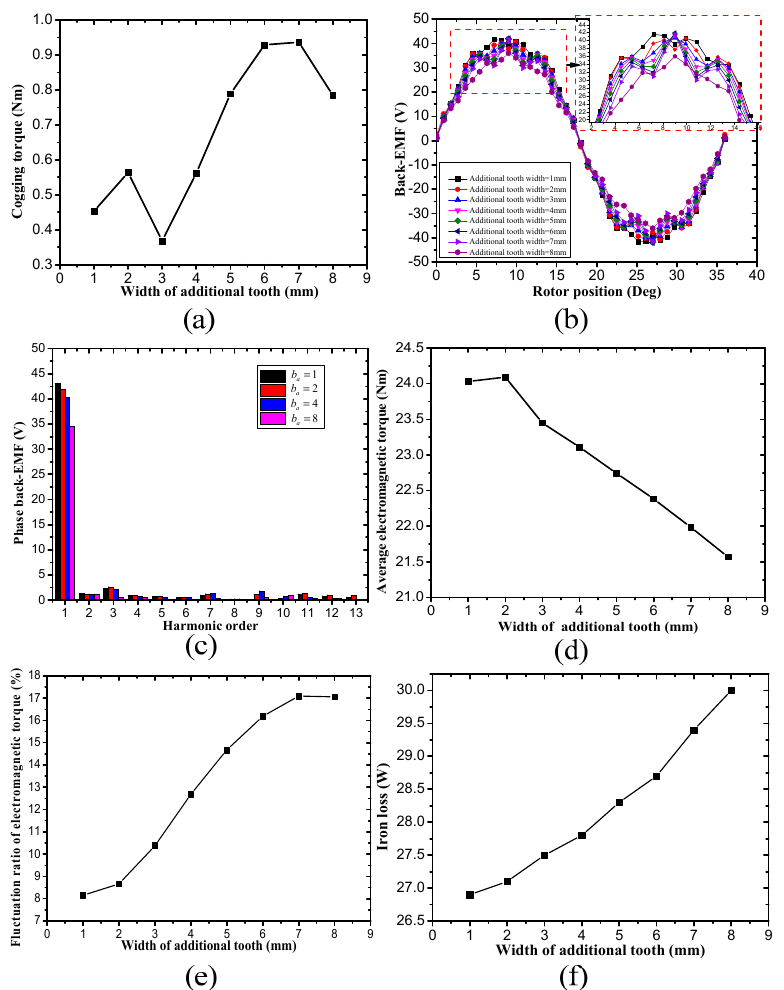
Figure 14. Influence of the additional tooth width ( a ) Cogging torque ( b ) Back—EMF ( c ) Harmonic analysis of the phase back EMF ( d ) Average electromagnetic torque ( e ) Fluctuation ratio of electromagnetic torque ( f ) Iron loss.